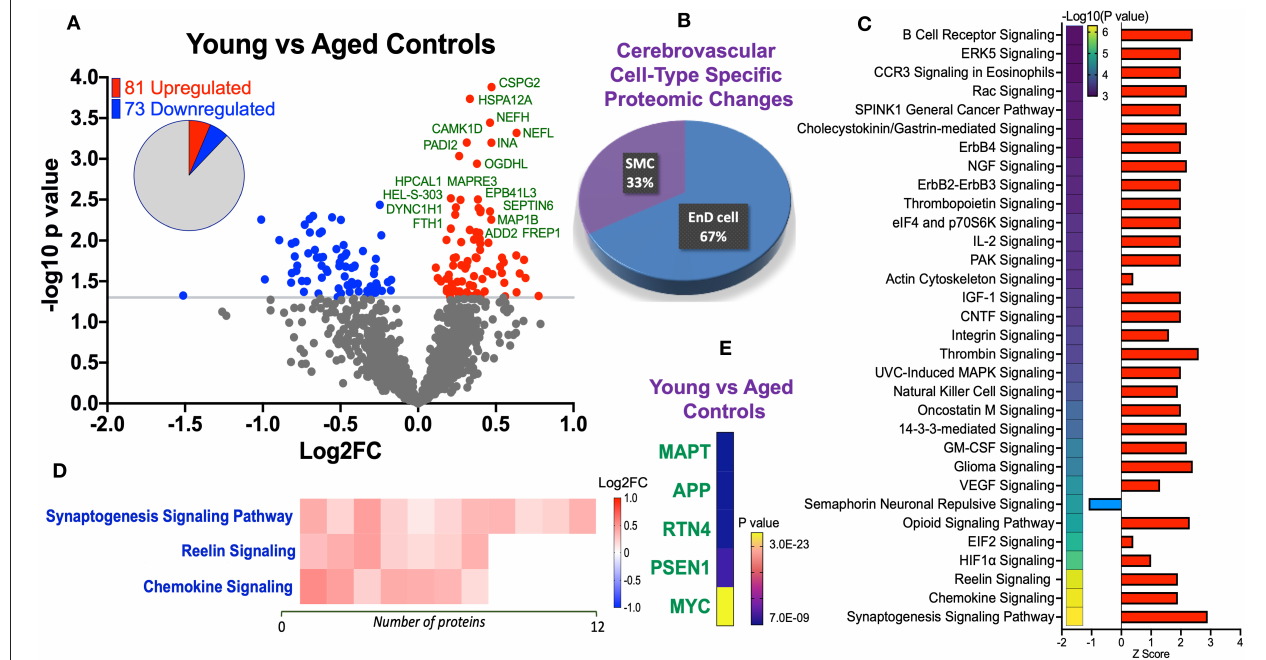
FIGURE 3 | Proteomic changes, cell origin, signaling pathways, upstream regulator factors observed in the cerebrovasculature isolated from the inferior frontal gyrus of young and aged controls. (A) Volcano plot of differentially expressed proteins in young and aged controls (pie chart inset shows up/down-regulated proteins, significant cut off set at 1.3 and red and blue points indicated up- or down-regulated significant proteins, respectively). (B) Pie Chart show origin of cell types where significant proteins from the comparisons between young and aged controls are observed. Data are generated from the number of significantly regulated proteins per specific cell type (from the PanglaoDB omic database), expressed as a percentage. (C) Canonical pathways identified from ingenuity pathway analyses [data depict –log10 ( P -value) and Z score generated from Fischer test of an overlap with the IPA knowledgebase; blue—downregulated and red—upregulated], and (D) shows heat map of the top 3 pathways and the corresponding number of significantly regulated proteins altered per pathway and their Log2 fold change expression level. (E) Shows Top 5 identified upstream regulators from the ingenuity pathway analyses of differentially regulated proteins in young vs. aged control cases.